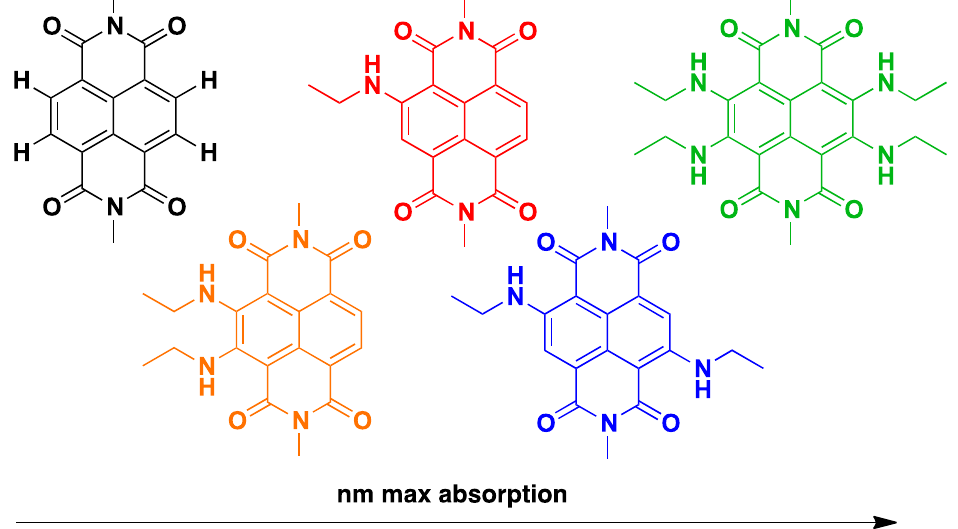
Figure 6. A rainbow collection of cNDIs.